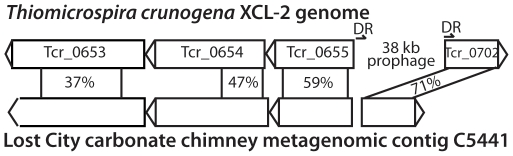
The prophage genome identified in T. crunogena is not present in the Lost City metagenome.ORFs on both sides of the prophage are present in Lost City metagenomic contig C5441 (accession # ACQI01005441), but a possible direct repeat (upstream region has 88% identities with positions 24–49 of Tcr_0702) is absent. Amino acid identities and alignment lengths (as calculated by blastp) are shown.